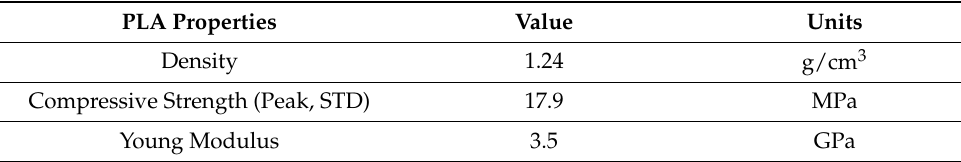
Table 1. Mechanical properties of PLA.